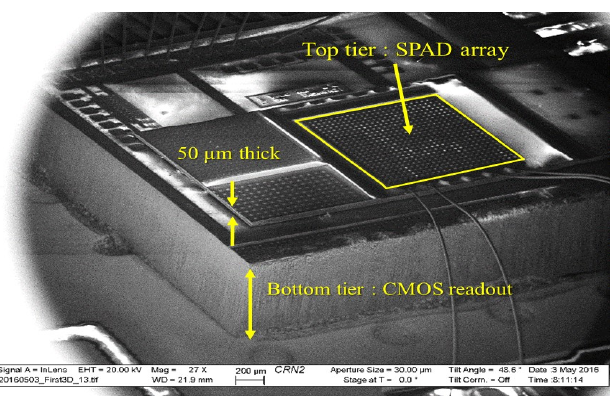
Figure 7. SEM image of Sherbrooke’s first 3D PDC. The top layer includes a 22 × 22 p + n SPAD array with a 50 µm pitch and was im- plemented in Teledyne-DALSA Semiconductor Inc (TDSI) 0.8 µm CMOS process